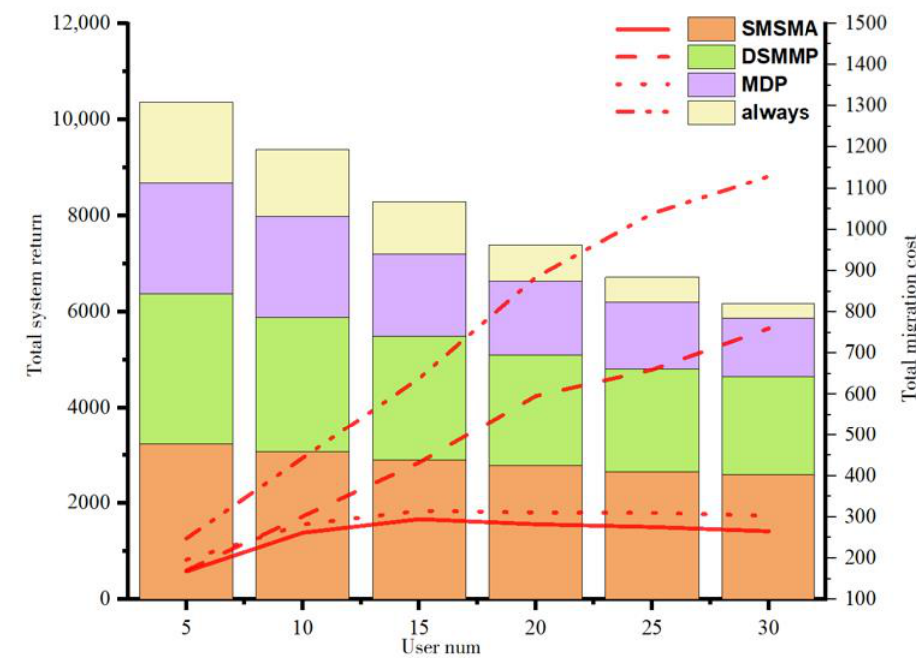
Figure 12. The effect of the number of users on the total return of the system.